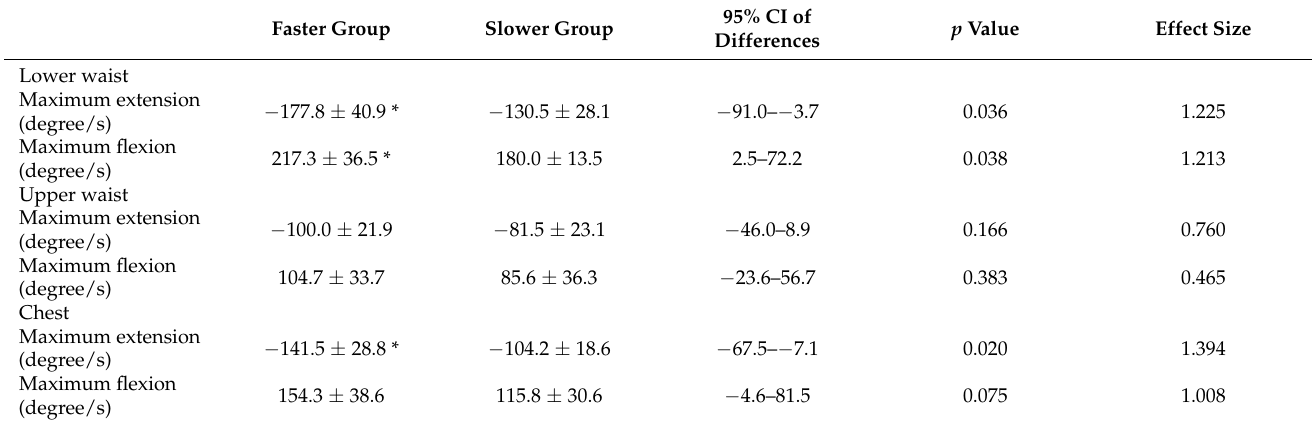
Table 4. The maximum extension and flexion angular velocity of the lower waist, upper waist, and